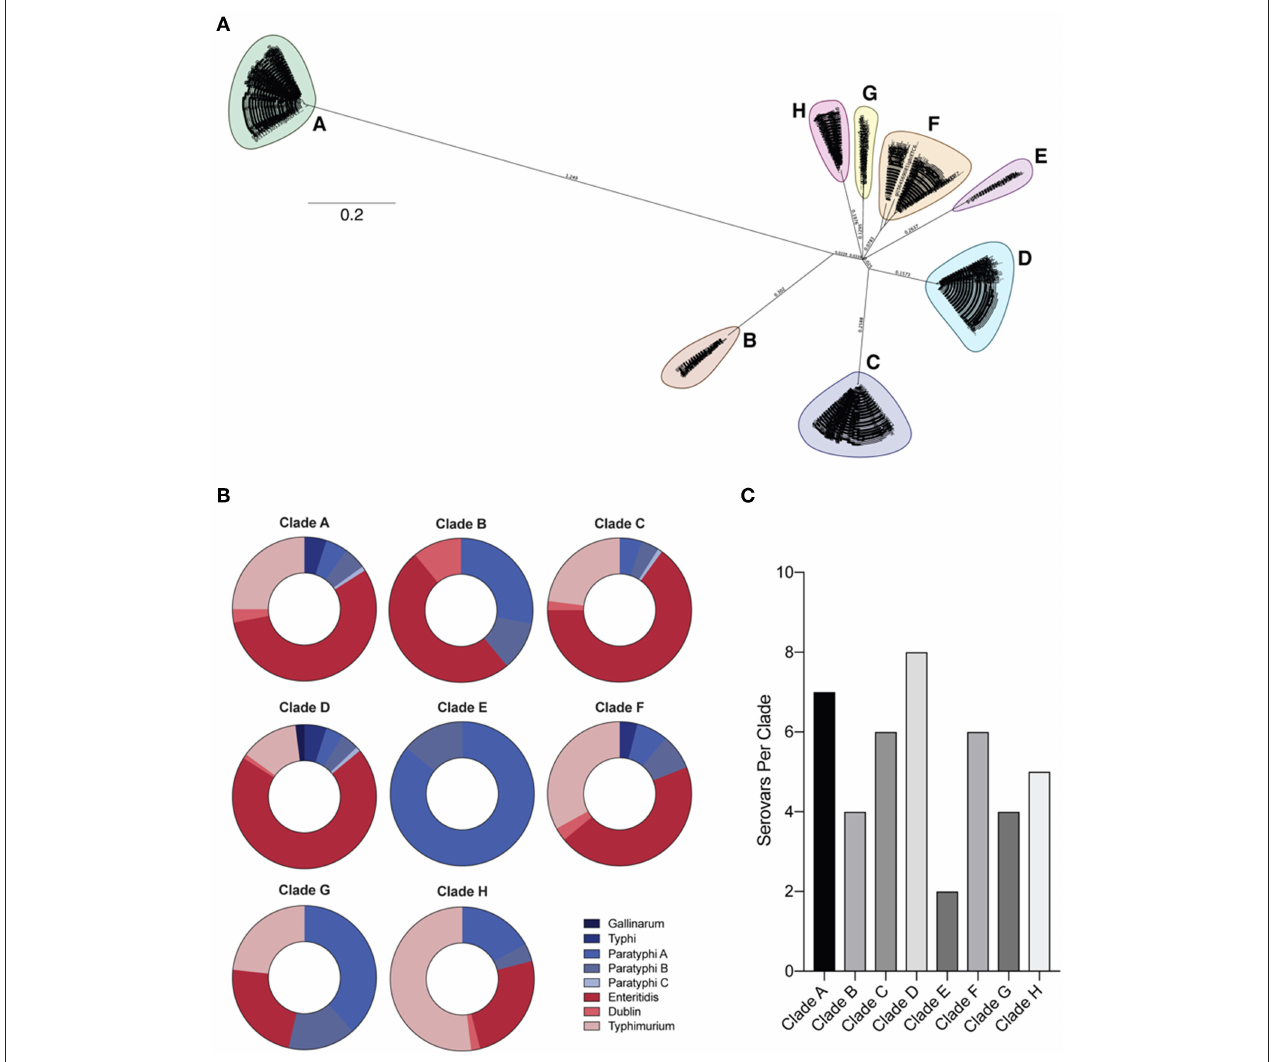
FIGURE 1 | Phylogeny of Salmonella OmpC protein. (A) Neighbor-joining tree of full-length Salmonella OmpC protein sequences. Full-length Salmonella OmpC protein sequences used to create a neighbor-joining tree using the Jukes-Cantor model with 100 bootstraps. Outgroups separated into 8 clades (A–H). (B) Prevalence of typhoidal and non-typhoidal Salmonella serovars among each OmpC clade. Full-length OmpC protein sequences were retrieved from NCBI and aligned using Clustal Omega, and intra-serovar OmpC conservation was assessed using in-house developed software utilizing a sliding window approach (for a detailed description see methods). The percentage of each Salmonella serovar OmpC amino acid sequence within Salmonella clades is shown. Typhoidal serovars are shown in blue while non-typhoidal serovars are shown in red. (C) Number of serovars per clade represented by a bar chart.